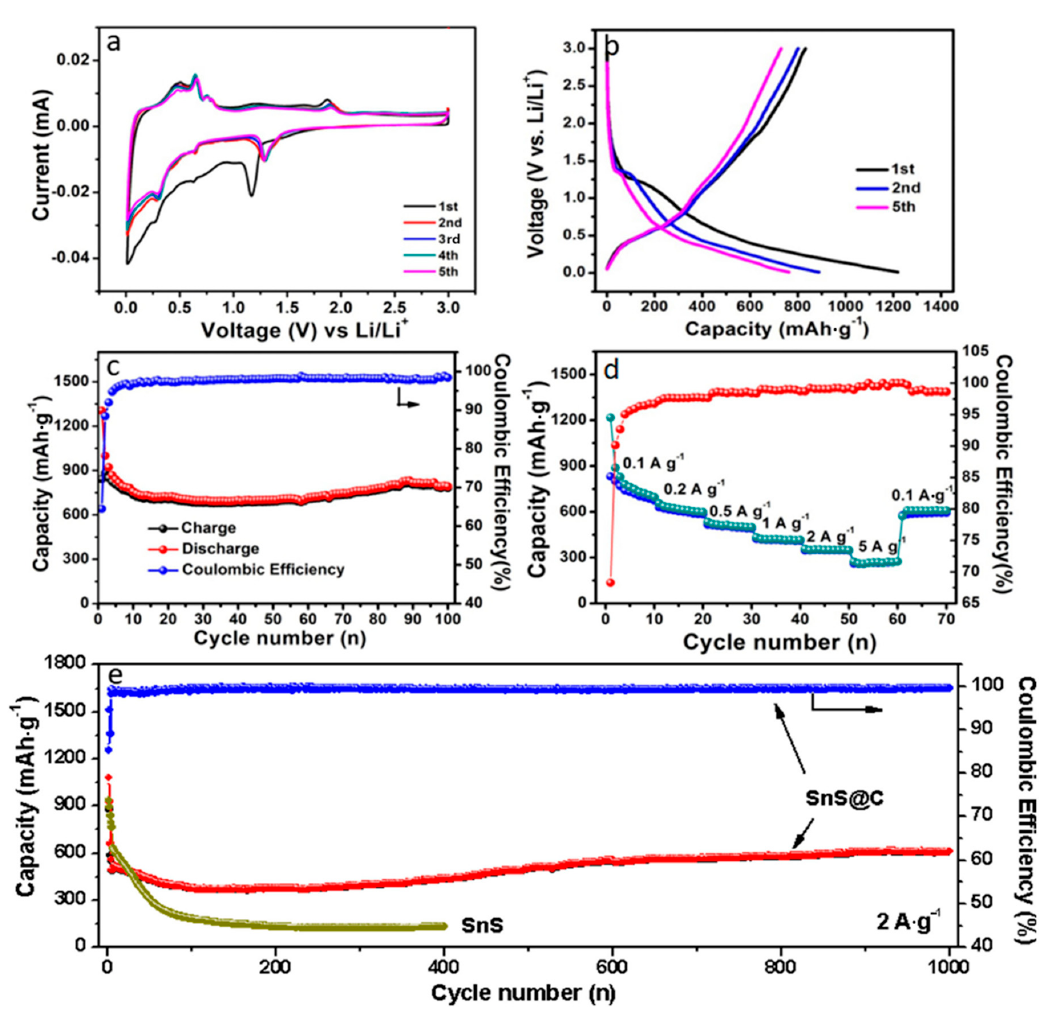
Figure 5. ( a ) CV curves; ( b ) discharge/charge profiles for the first, second and fifth cycle; ( c ) cycling performances at 100 mA·g − 1 for 100 cycles; ( d ) rate capability at various current densities of SnS@C composites and ( e ) long-term cycling performances of SnS and SnS@C composites at 2 A·g − 1 for LIBs. Except for LIBs, the SnS@C composites were also used as anode materials for SIBs. The